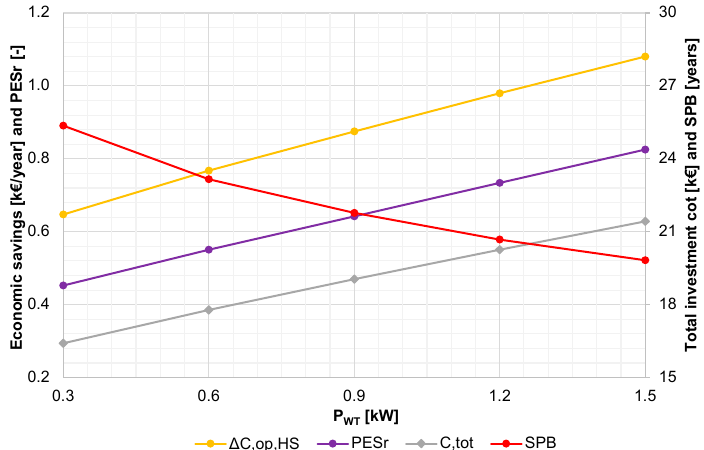
Figure 15. Primary Energy and economic parameters of the system vs. variation of the WT power, parametric analysis.